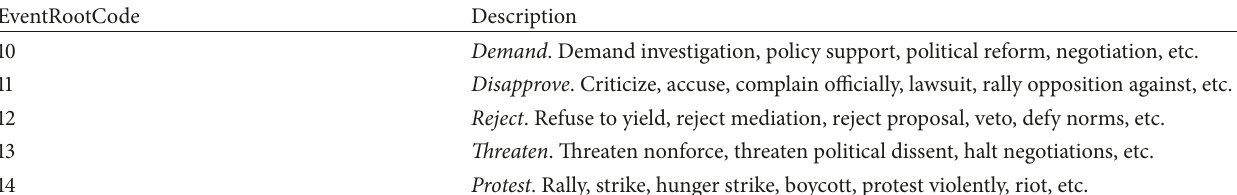
Table 1: The EventRootCode and descriptions.